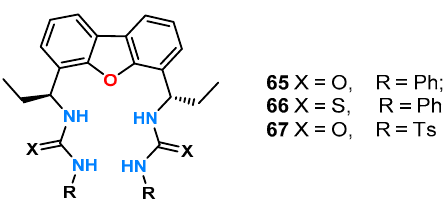
Figure 21. Dibenzofuran receptors 65 – 67.